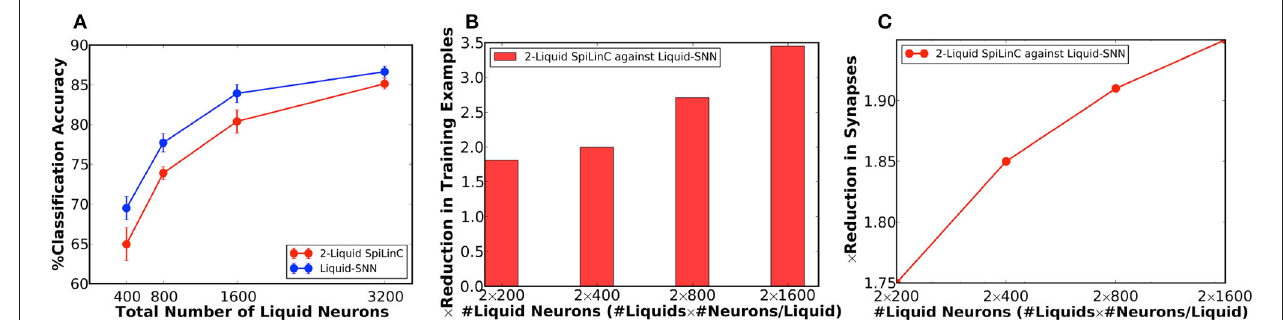
FIGURE 4 | (A) Classification accuracy of two-liquid SpiLinC and Liquid-SNN vs. the total number of liquid neurons, evaluated on 2,542 test samples from the TI46 digit subset. (B) Reduction in the number of training examples offered by two-liquid SpiLinC over Liquid-SNN. (C) Sparsity in synaptic connectivity offered by two-liquid SpiLinC over Liquid-SNN.